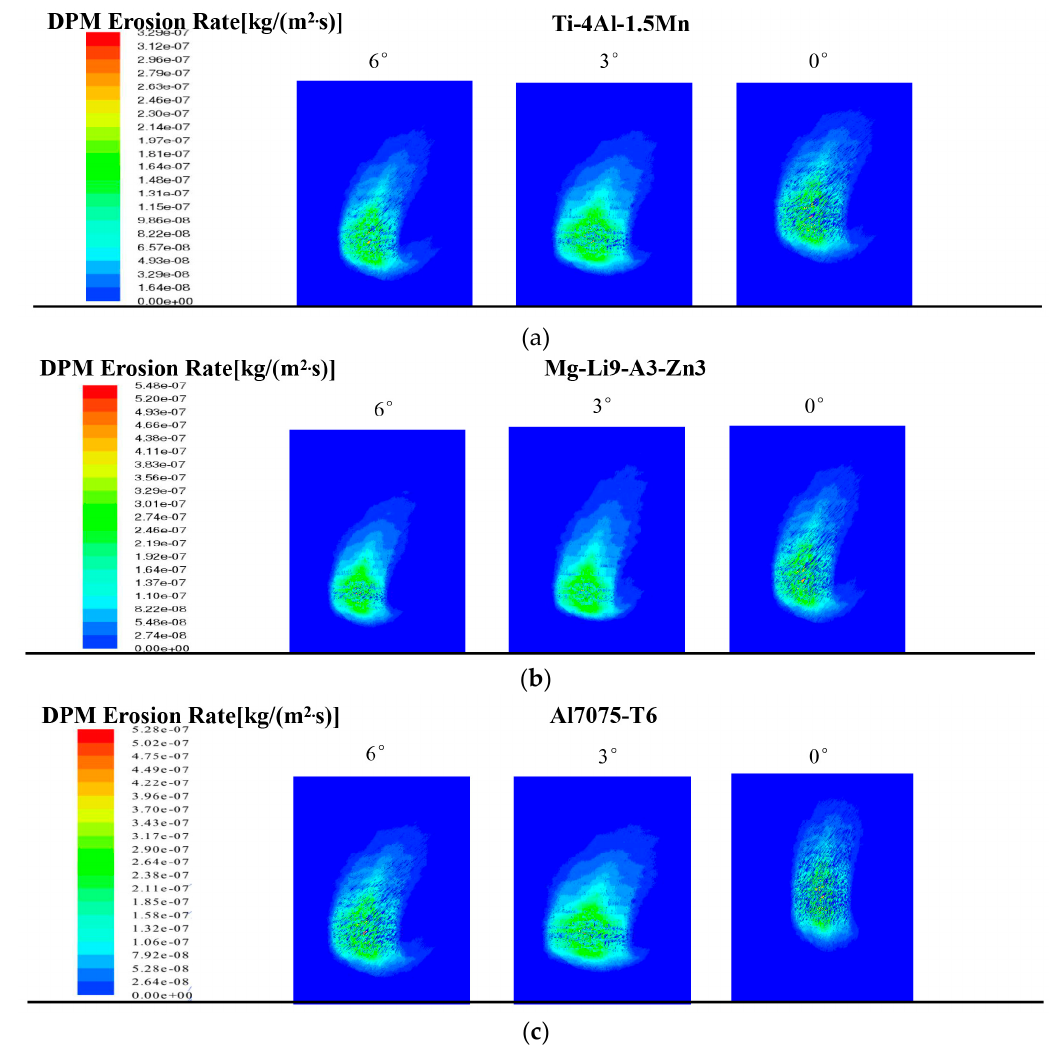
Figure 11. Three-dimensional erosion rates of the three materials at different angles of attack at impact speed of 220 m/s: ( a ) Ti-4Al-1.5Mn; ( b ) Mg-Li9-A3-Zn3; ( c ) Al7075-T6.